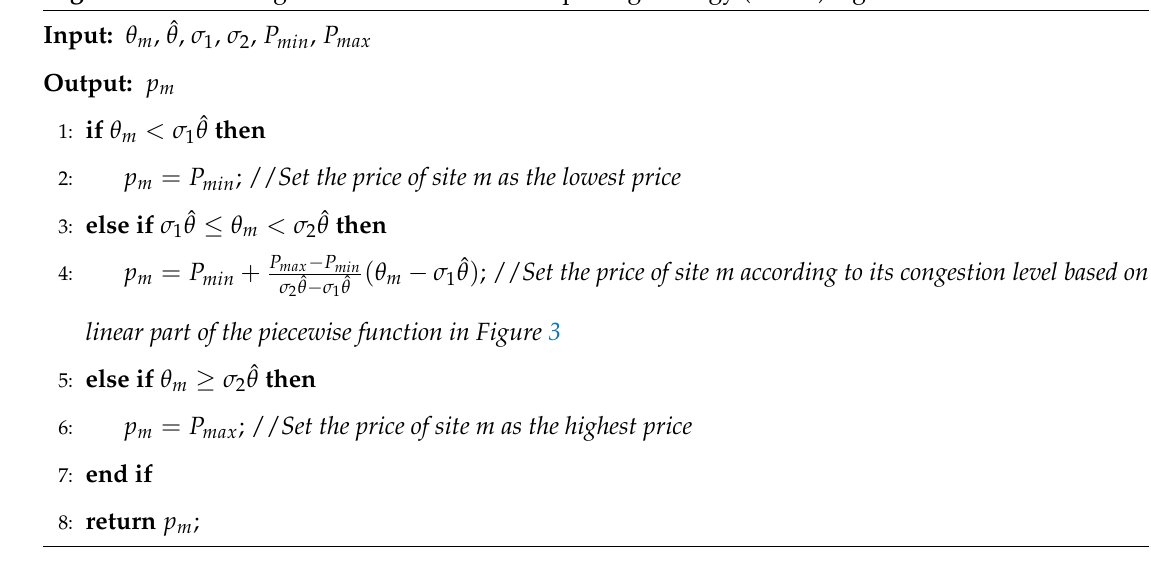
Figure 3. The relationship between congestion level and bandwidth price. Algorithm 1 The congestion-aware bandwidth pricing strategy (CABP)